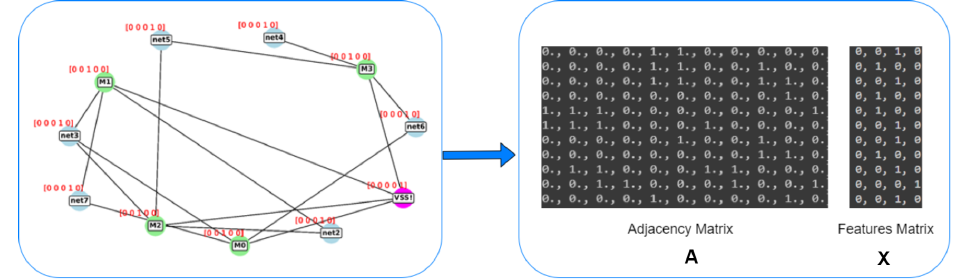
Figure 8. Dataset preprocessing: Converting the netlist to annotated graphs, then representing each graph with adjacency and feature matrices.